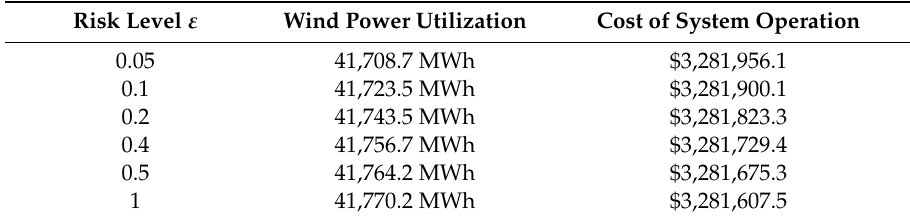
Table 8. Results of di ff erent risk levels ε .